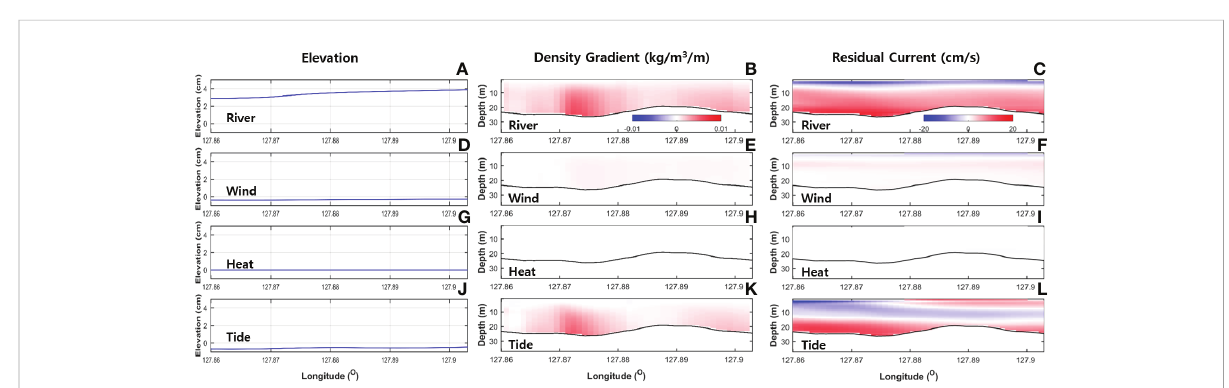
FIGURE 11 Differences (Control – Sensitivity) in the surface elevation, density gradient (kg/m 3 /m), and residual current of the control experiment and the (A – C) river, (D – F) wind, (G – I) heat, and (J – L) tide experiments for the vertical pro fi le along Noryang Channel averaged from 26 June to 24